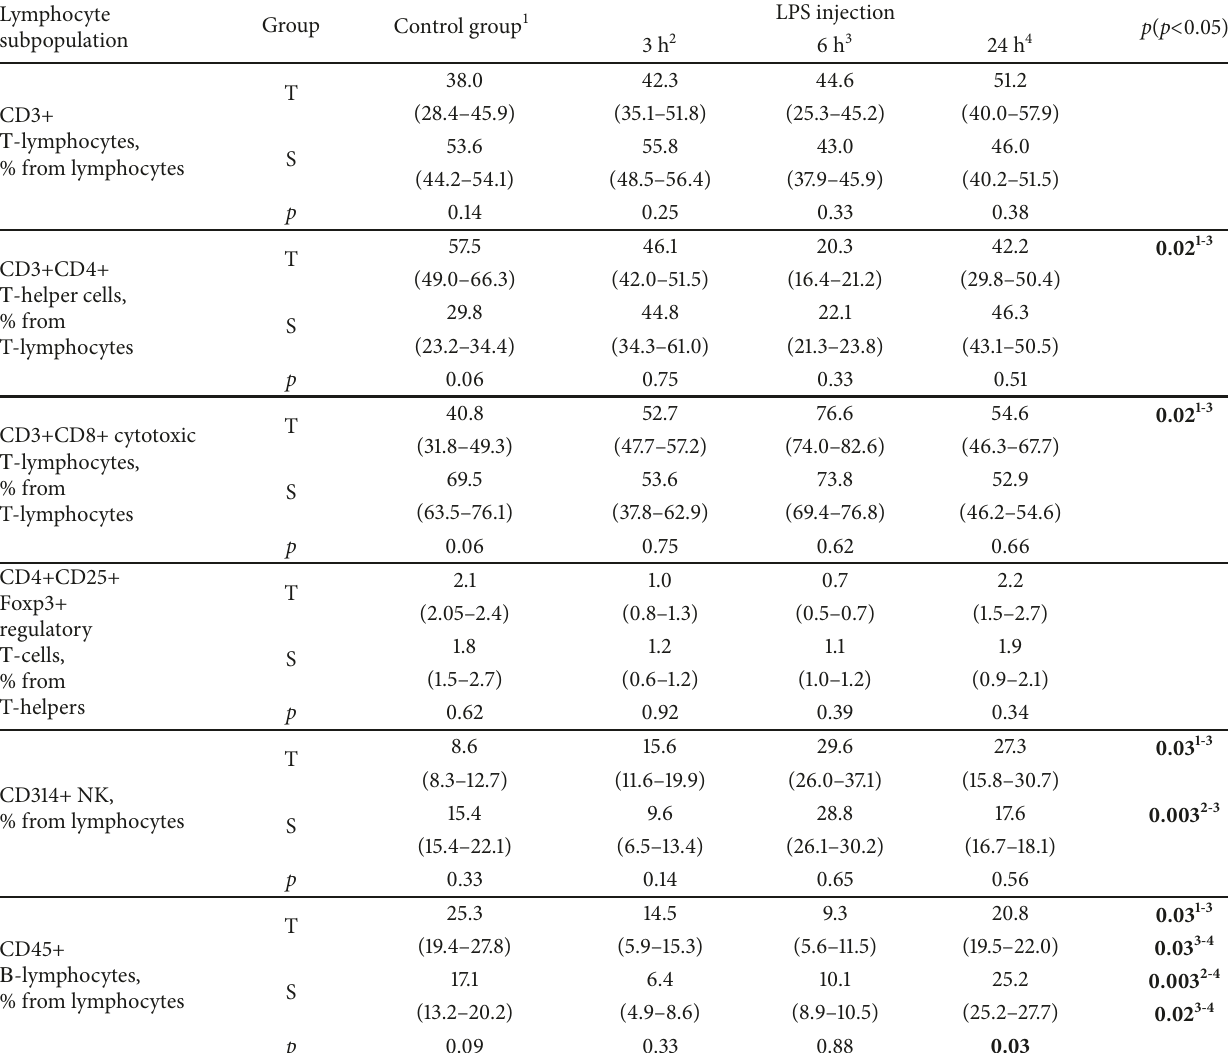
Table3:Subpopulationoflymphocytesintheperipheralbloodoftolerant-(T)andsusceptible-(S)to-hypoxiaWistarratsin3,6,and24hours after LPS injection. Data are presented as median (25%, 75%); the statistical significance of differences ( p ) between tolerant and susceptible rats is determined by the Mann-Whitney 𝑈 test and between different time points after LPS injection by the Kruskal-Wallis method ( 𝑛 = 5 in each